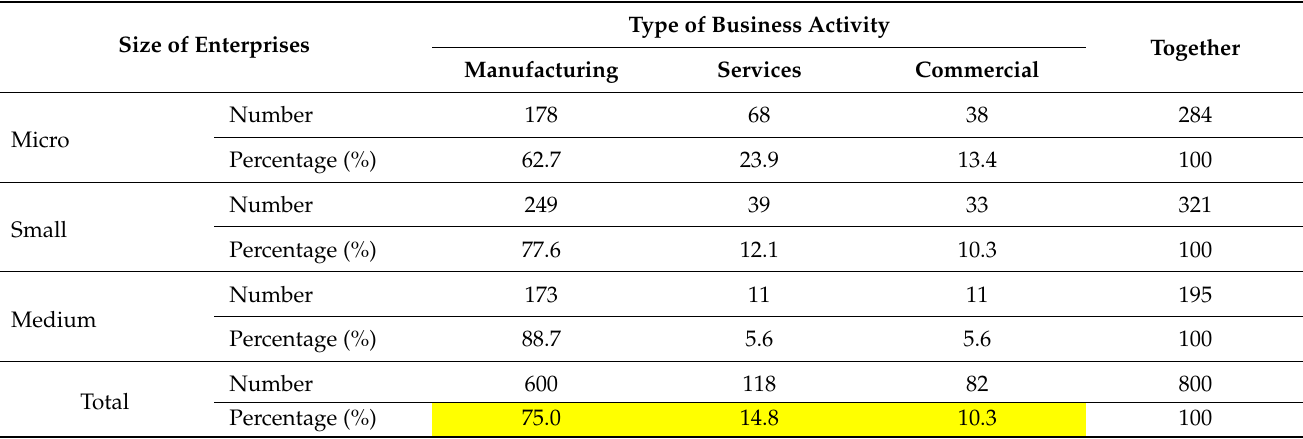
Table 2. Division of the study sample according to type of economic